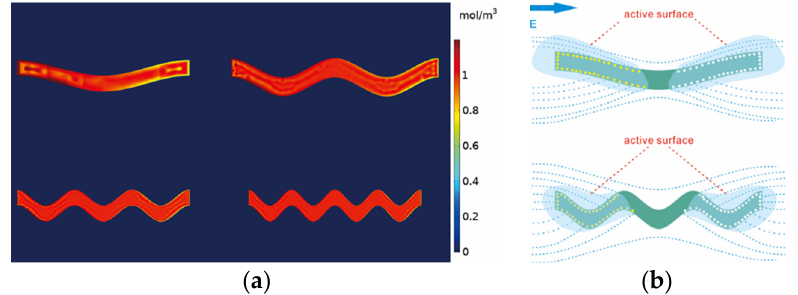
Figure 11. Influence of the tortuosities of vein metal sulfides on the migration of electrons during the induced polarization. ( a ) The numerical simulation results for the concentration distributions of electrons inside the vein metal sulfide models with various tortuosities just after the cutoff. ( b ) Schematic representation of the surface charge distributions around polarized vein metal sulfides with different